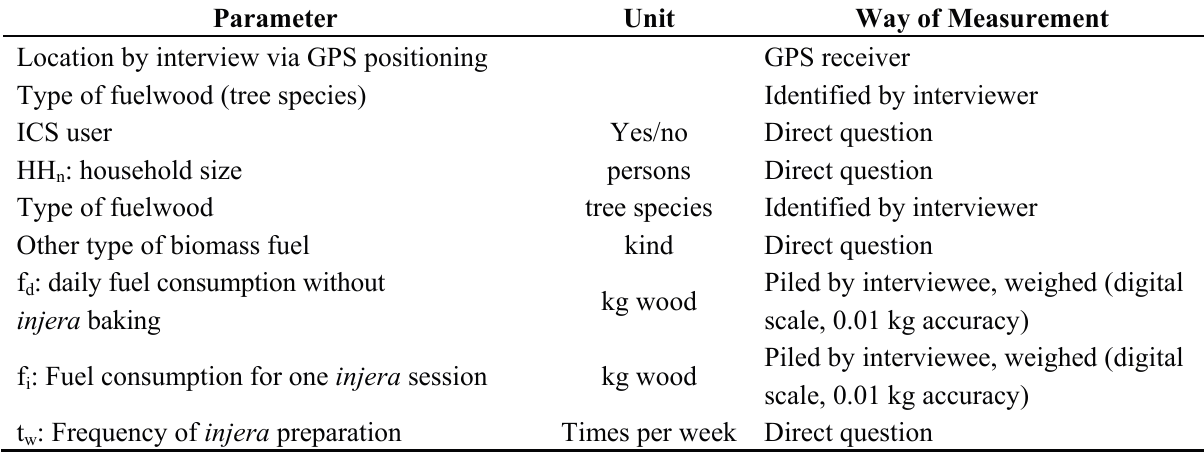
Table 3. Relevant parameters assessed in the field